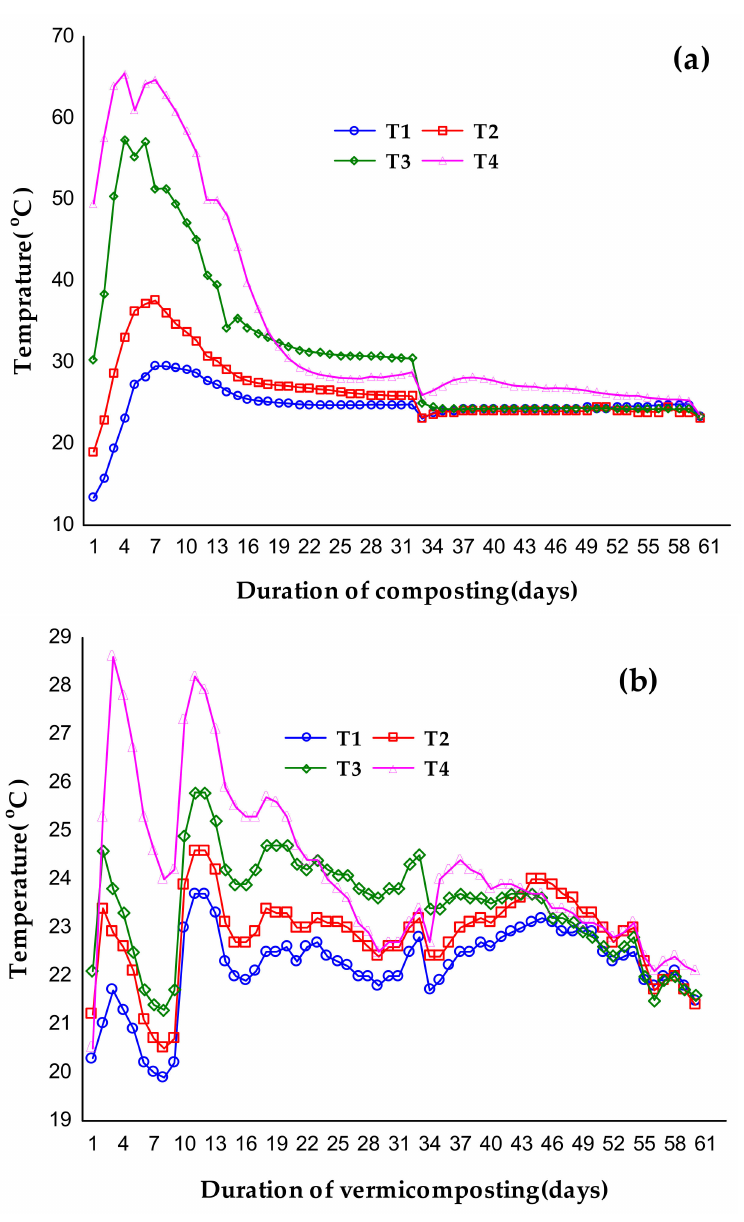
Figure 1. Evolution of temperatures during the composting ( a ) and vermicomposting ( b )